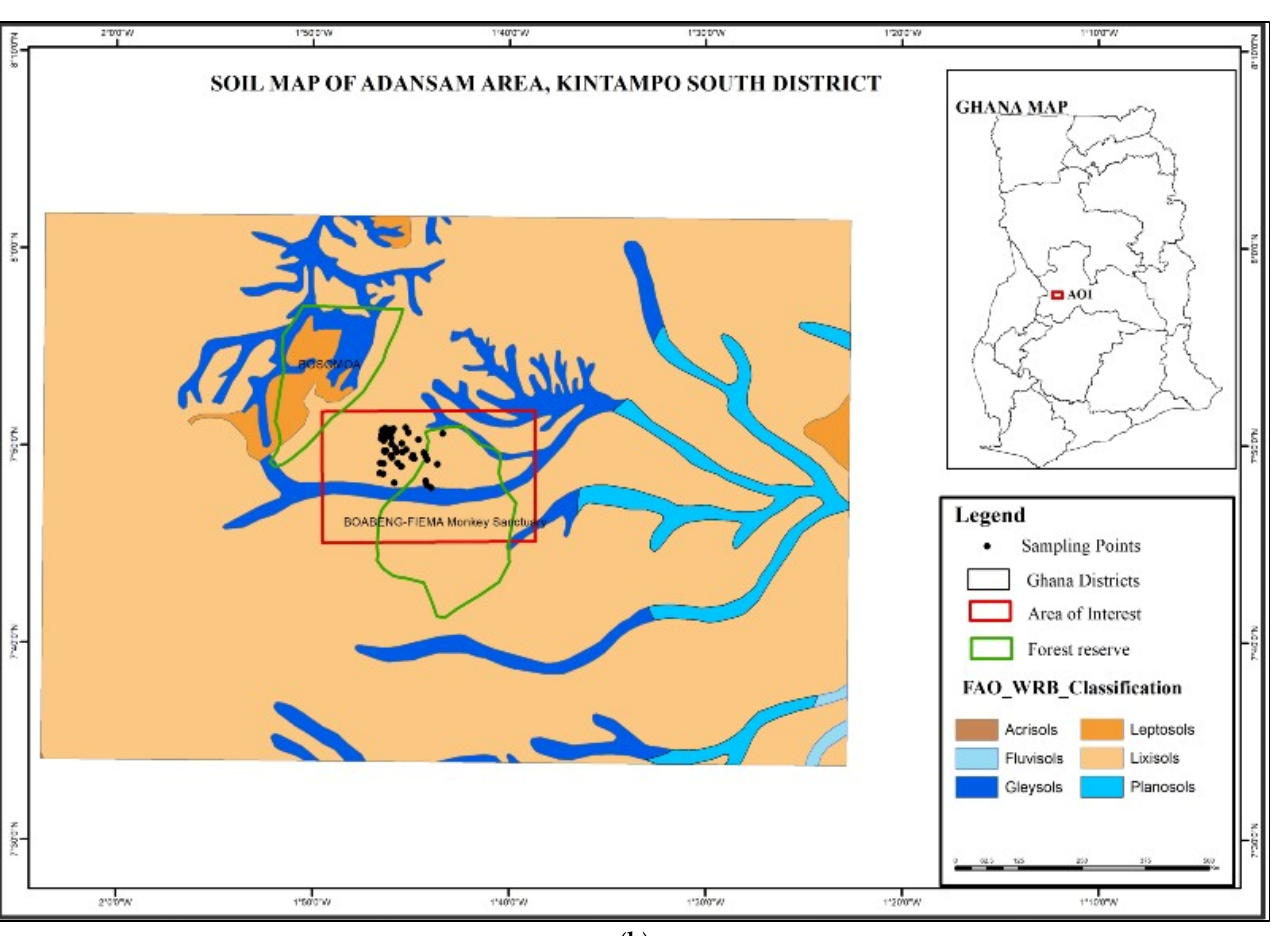
Figure 1. The study area showing sampled locations (black dots) at ( a ) Dompem in the Forest zone and ( b ) Adansam in the Forest ‐ Savannah Transition zone. Table 1. Farm types, corresponding wealth rankings and numbers of farms per wealth ranking and farm type.